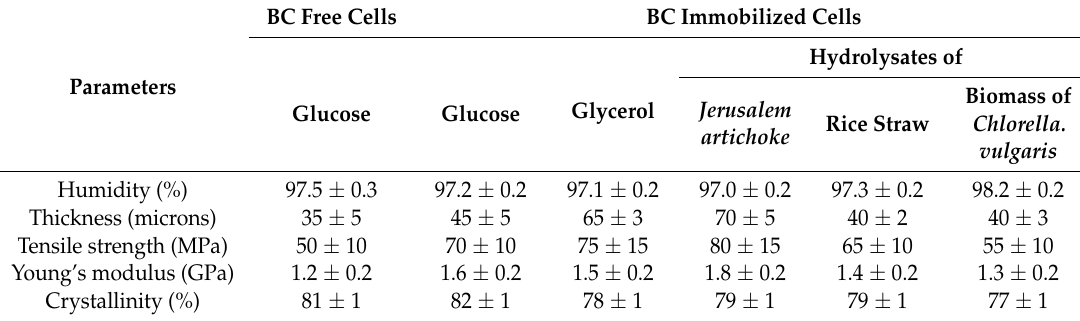
Table 5. Properties of the BC produced by Komagataeibacter xylinum B ‐ 12429 cells in free and immobilized forms under identical conditions.